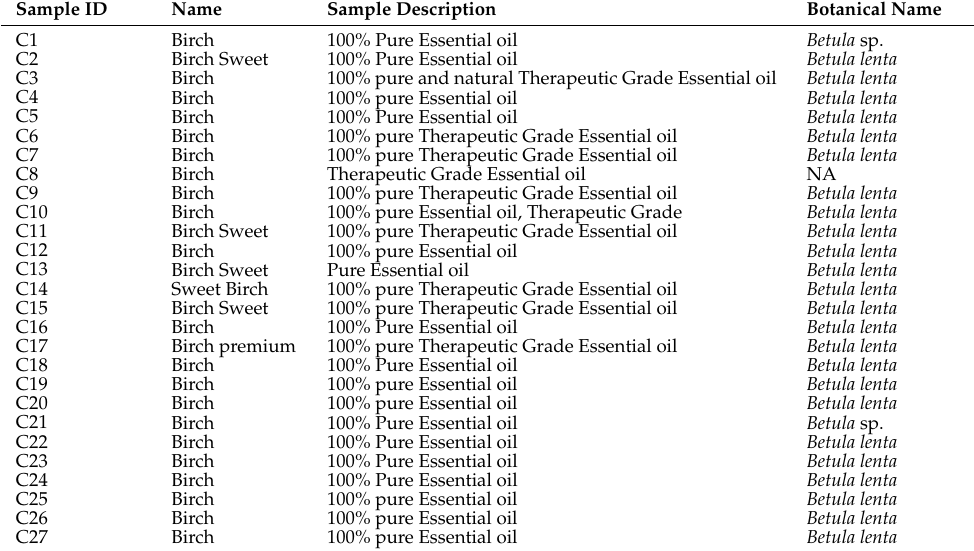
Table 1. Available information on commercial sweet birch